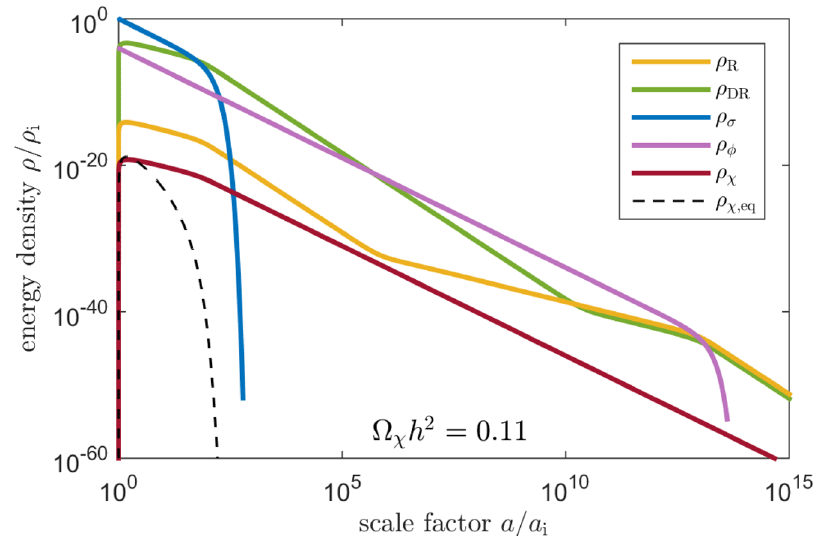
Figure 5 . Numerical evolution of the system in (5.9)–(5.13). Curves depict the energy densities as functions of scale factor in our scenario. Numerical values of the underlying parameters correspond to the benchmark values given in table 1. DM is primarily produced from inflaton decay, with a negligible thermal contribution, establishing the observed relic abundance.